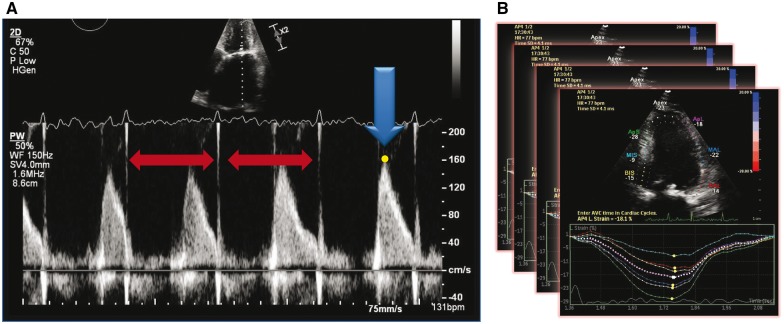
Example of optimal acquisition (index beat method). In order to achieve the most valid and reproducible measurement in atrial fibrillation, parameters should be acquired where the two preceding cardiac cycles have similar RR-intervals and preferably where the equivalent heart rate is < 100 beats/min (panel A). This method can also be applied to assessment of function; averaging individual index beats is preferable to averaging across sequential cardiac cycles (panel B).